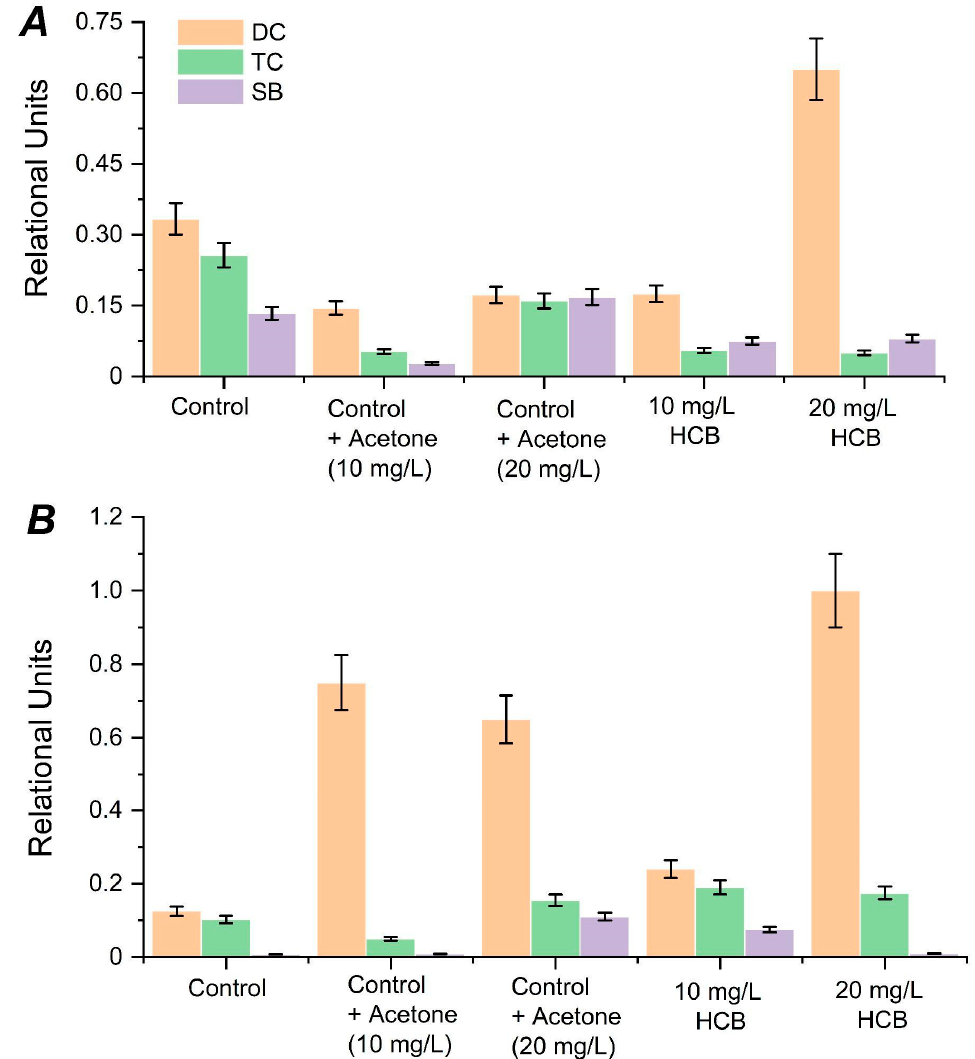
Figure 1. Lipid peroxidation indicators in the cells of bacterial strain B-400 ( A ) and strain B-401 ( B ) DC is diene conjugates, TC is triene conjugates, and SB is Schiff’s bases. The malondialdehyde content, as a secondary POL product, was higher in the ex- perimental variants than in the pure control. MDA presence in the cell indicates a high probability of the formatting triene conjugates, Schiff’s bases, to cause significant distur- bances in the functioning of cell membranes. Nevertheless, some researchers [24,25] believe that the MDA indicator is the last thing to pay attention during justifying the physiological response of a cell to stress, since its high level indicates the further POL formation, but with an increase in the concentration of toxic substances, MDA does not increase, and the resistance mechanisms are actively functioning (Figure 2). It should be noted that at 10 and 20 mg/L, HCB doses in the B-400 strain cells, the MDA level was lower than in the pure control, and in the B-401 strain, it was almost two times higher; however, when the dose was further increased to 20 mg/L HCB, MDA level did not increase compared to 10 mg/L HCB. Presumably, under HCB presence, the membrane saturation level in the B-400 strain significantly increased, compared to the pure control, and MDA is formed by the free radical’s interaction with the CH3-ends of unsaturated fatty acids, so MDA level decreased significantly. The MDA content in the cells from the B-401 strain did not differ at 10 and 20 mg/L HCB doses, which can also be explained by a minor increase in the saturation level of cell